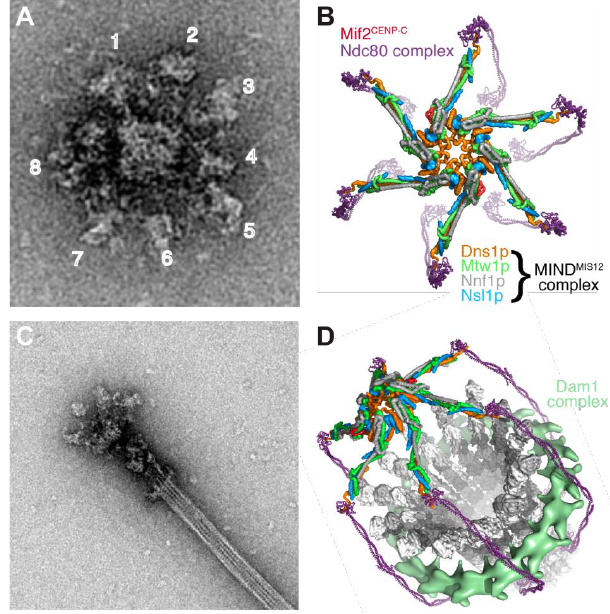
Figure 7. Images and structural model of budding yeast kinetochore particles. ( A ) Negative stain electron micrographs showing a kinetochore particle isolated from S. cerevisiae [291]. Images in this panel and in C courtesy of Sue Biggins and Tamir Gonen; ( B ) A rendered image with possible molecular interpretation of the negatively stained particles showing MIND MIS12 :CENP-C complexes departing from a central “hub” and connecting with Ndc80 complexes. Image reproduced with permission from reference [240]; ( C ) Negative stain electron micrographs showing a S. cerevisiae kinetochore particle bound to the end of a taxol-stabilized microtubule [291]. Image courtesy of Sue Biggins and Tamir Gonen; ( D ) The structure in ( B ) is shown to surround the microtubule in end-on configuration. The Dam1 complex stabilizes the arrangement by surrounding the microtubule. Image reproduced with permission from reference [240].